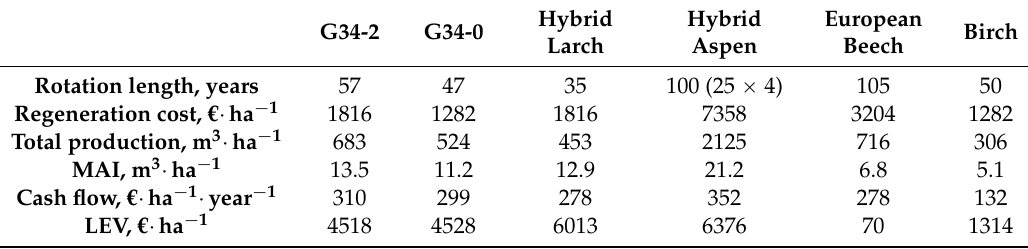
Table 2. Calculated volume productions and economic returns for Norway spruce, hybrid larch, hybrid aspen, European beech and birch stands in southern Sweden. The values for hybrid aspen are based on four 25-year rotation periods. Land expectation value (LEV) calculated using a 2.5% discounted interest rate. Cash flow is the movement of money (incomes minus costs) during the rotation without a discounted interest rate. MAI= Mean Annual volume Increment. G34-2 means a Norway spruce stand with site index 34 and two thinnings were done before final